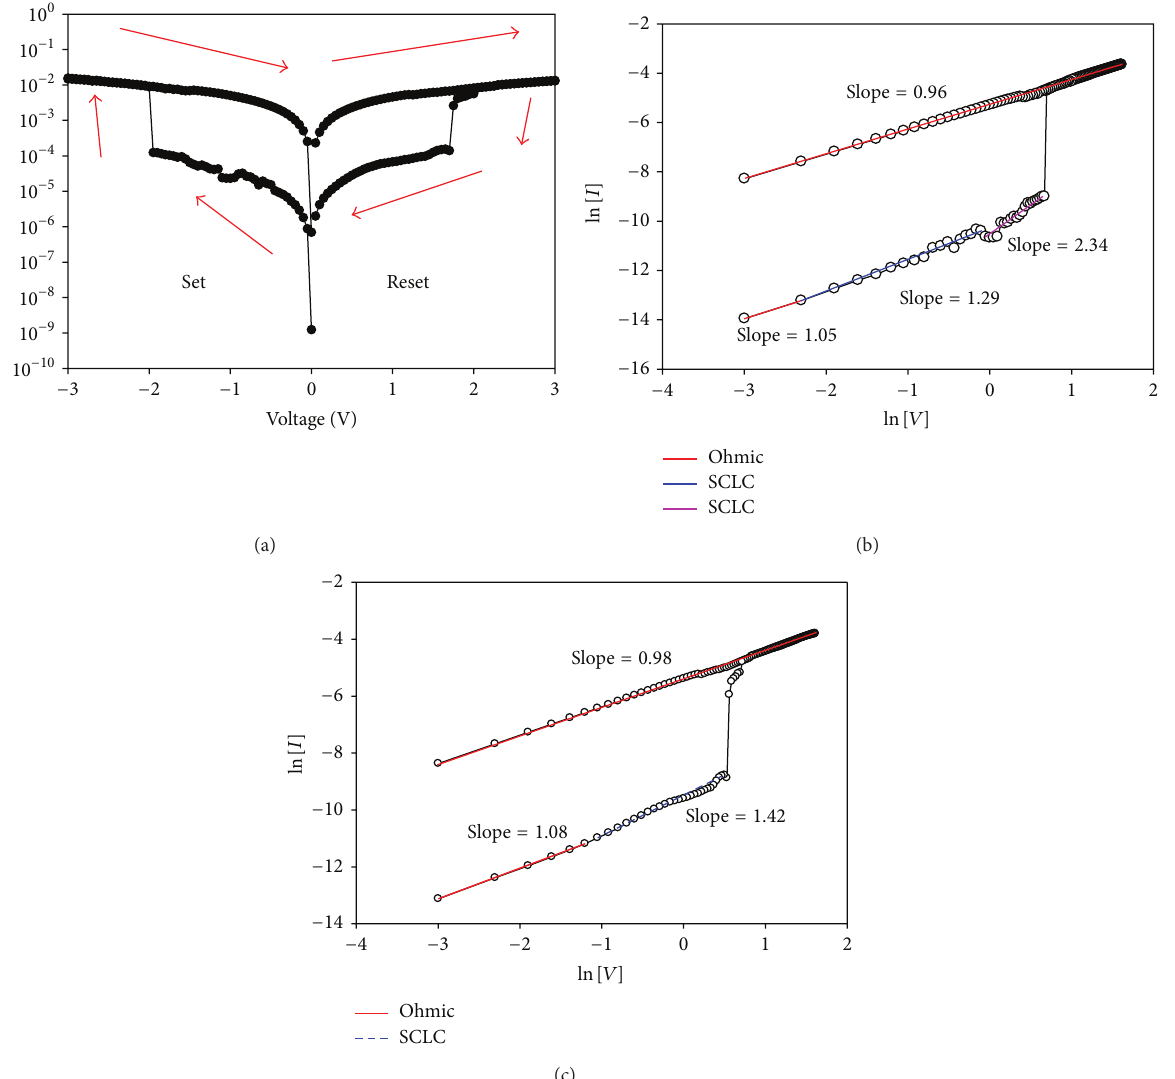
Figure 6: Current conduction mechanisms of the Al/CBTi144/ITO/glass RRAM cell annealed at 450 ∘ C: (a) in the entire switching operation, (b) during the Set process, and (c) during the Reset